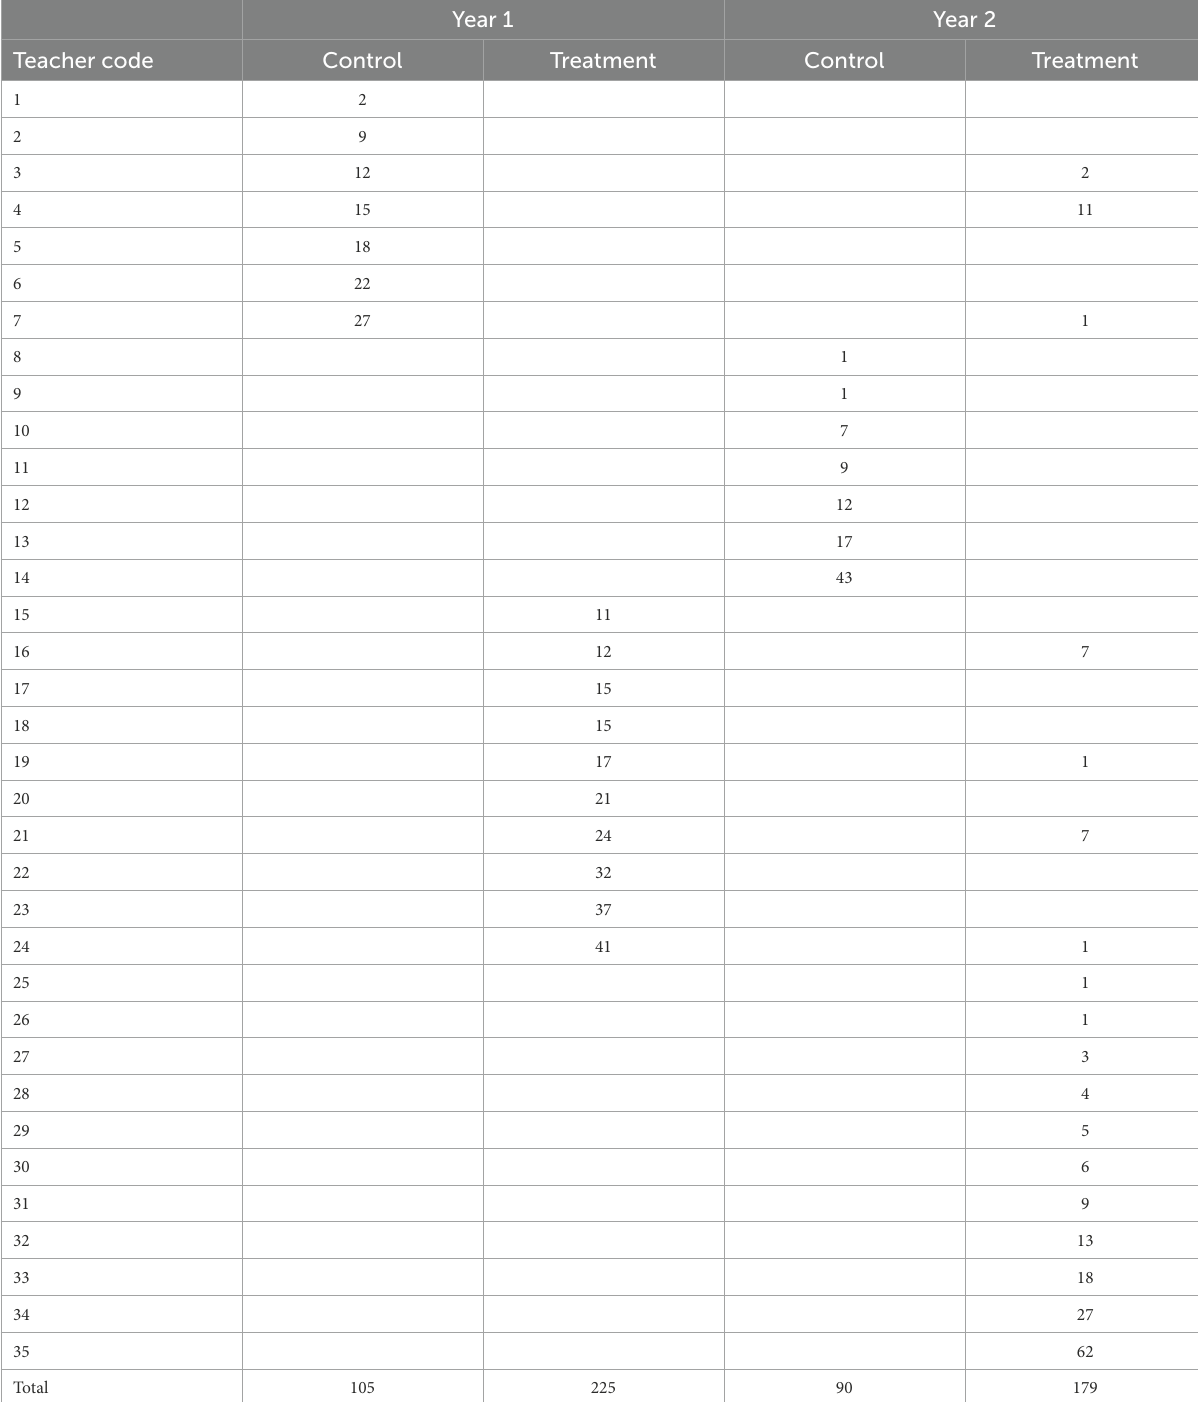
TABLE 2 Number of students associated with teachers across years and treatment groups (total teachers = 35; total students = 644; total control students = 204; total treatment students = 440). Several teachers participated for multiple years, with some switching from control to treatment groups in year